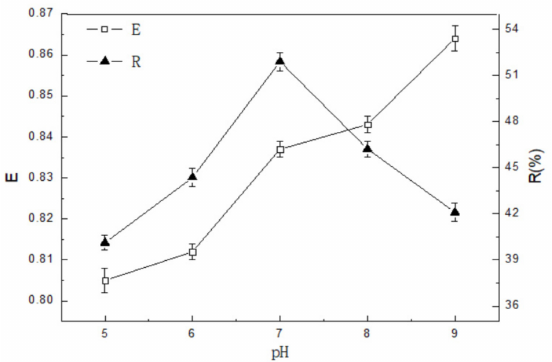
Figure 5. Effects of pH on enrichment ratio and